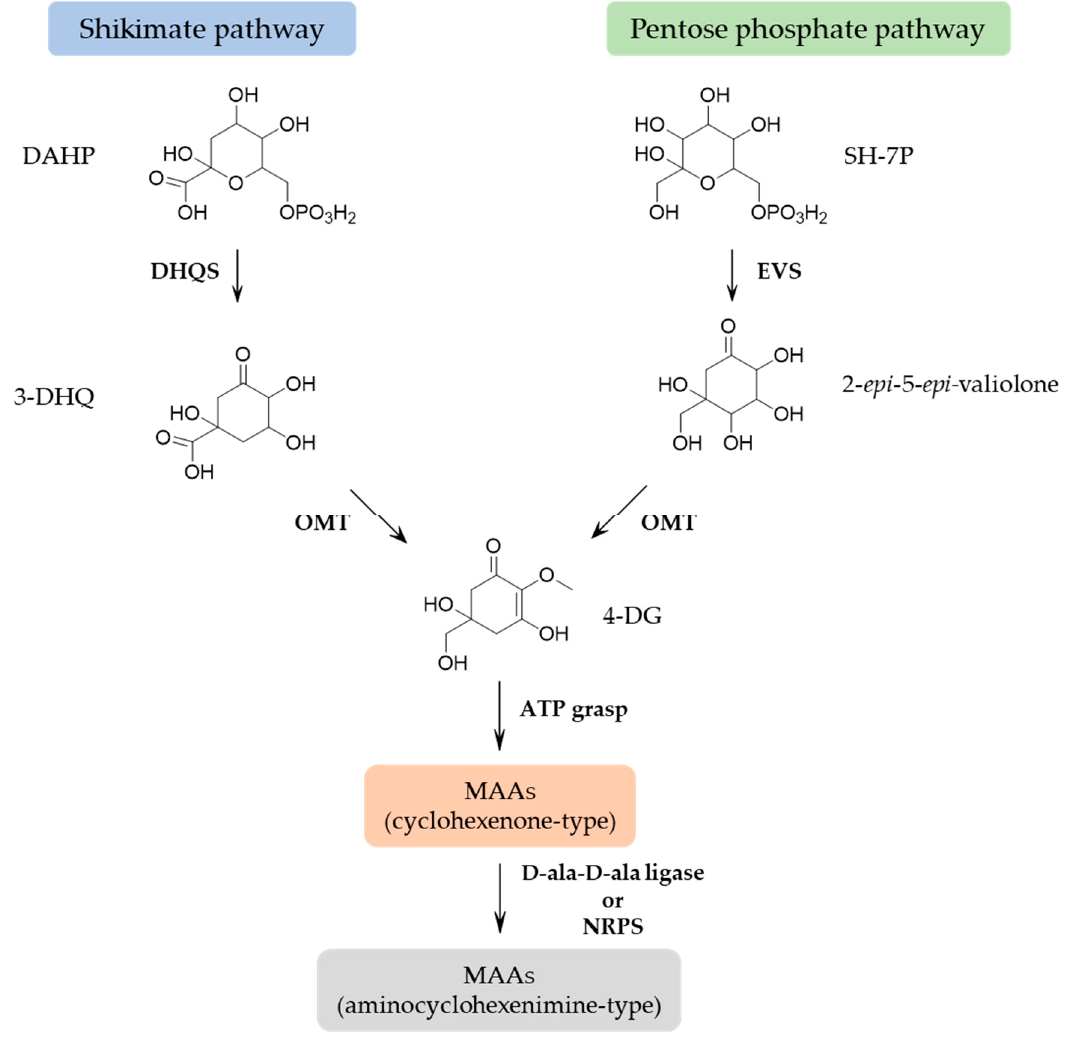
Figure 2. Proposed biosynthetic pathway of mycosporine-like amino acids. DAHP: 3-deoxy-D-arabino-heptulosonate phosphate, DHQS: 3-dehydroquinate synthase, 3-DHQ: 3-dehydroquinate, SH-7P: sedoheptulose-7-phosphate, EVS: cyclase-2- epi -5- epi -valiolone synthase, O MT: O -methyltransferase, 4DG: 4-deoxygadusol, ATP: adenosine triphosphate, NRPS: nonribosomal peptide synthase, D-ala-D-ala-ligase: D-alanyl-D-alanine ligase.